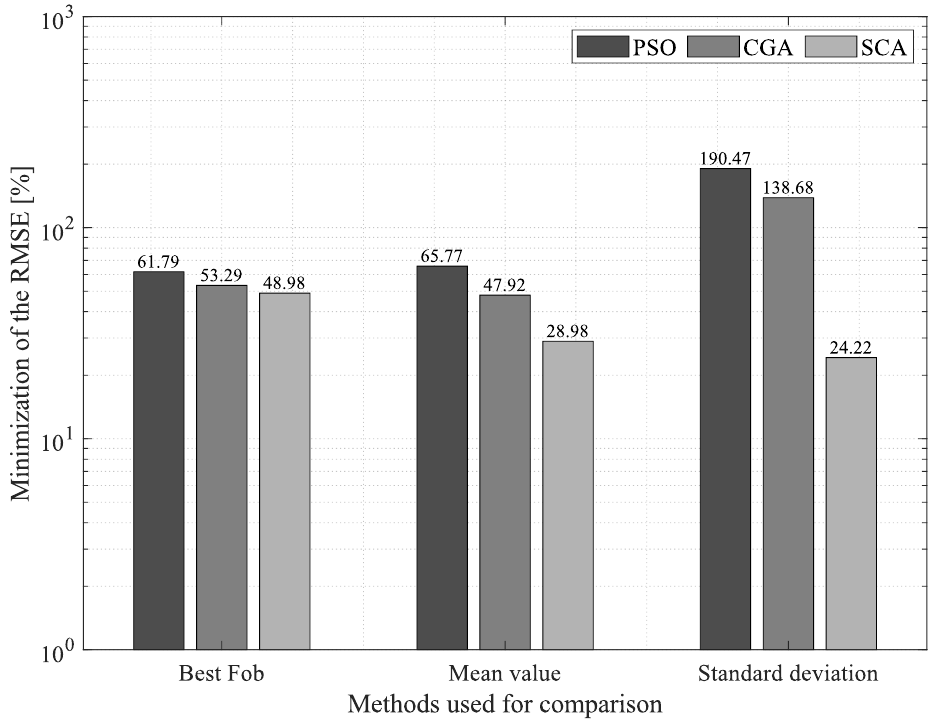
Figure 11. Robustness of the proposed solution methodologies in solving the parameter estimation problem of the TDM of the MSX 60 PV